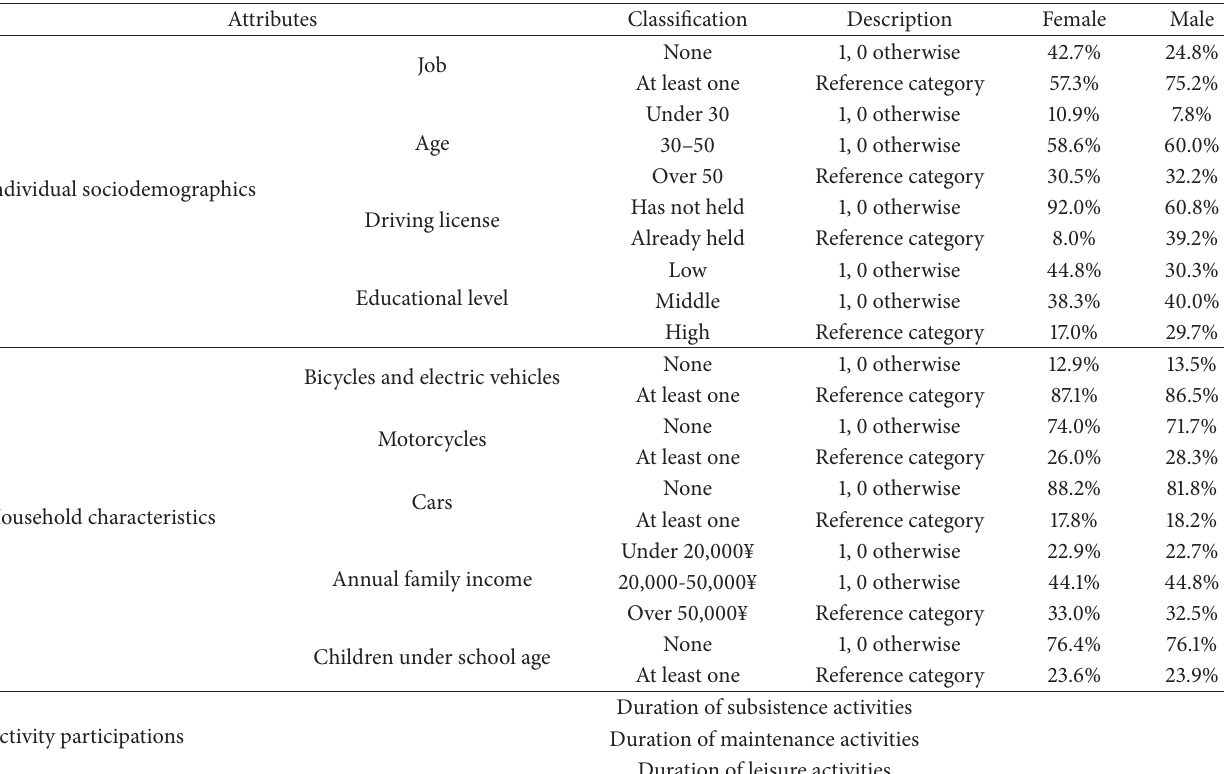
Table 1: Classification and description of independent